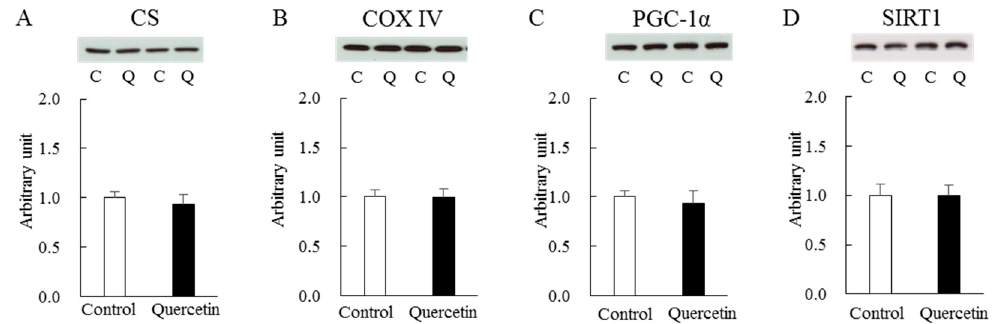
Figure 9. Effects of 7-day quercetin treatment on metabolic molecules in soleus muscles. Rats were assigned to either a control or quercetin groups and were maintained under ad libitum feeding for 7 days. After that, epitrochlearis muscles were dissected out as Western blot samples for CS (A), COX IV (B), PGC-1 α (C) and SIRT1 (D) A representative blot is shown above each figures. Values are means ± SE ( n = 7). All values were normalized by GAPDH abundance. C: control, Q: quercetin.